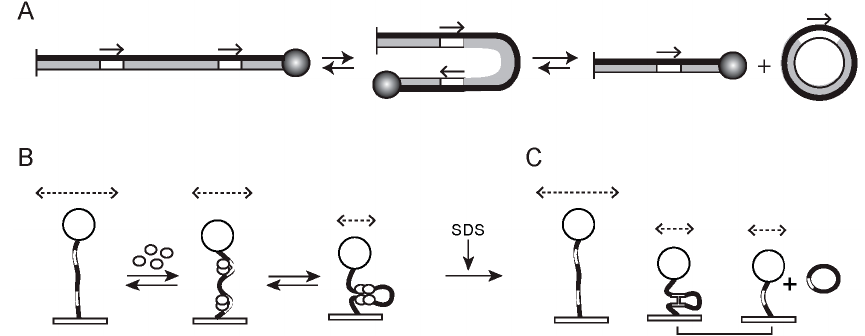
Figure 4. TPM analysis of tyrosine recombination between head-to-tail target sites. ( A ) The linear DNA substrate and the products of the recombination reaction are schematically drawn. The tethering surface and the polystyrene bead are shown as a short vertical line on the left and the sphere on the right, respectively. The relative orientation of the target sites is indicated by the direction of the arrows. ( B ) The changes in length of the DNA tether following the binding of the target sites by the recombinase and at subsequent steps of the recombination pathway are shown schematically. The relative magnitude of the BM amplitudes of the DNA–protein complexes are approximated by the lengths of the dashed, double-headed arrows drawn above the bead. The bound and bent target sites cause an apparent reduction in tether length, which is further accentuated by the synapsis of the bound sites. The exchange of one pair of strands to form the Holliday junction intermediate, or the completion of the excision reaction, will make this length reduction permanent. ( C ) The effect of removing the recombinase from the DNA by SDS addition is schematically illustrated. The non-synapsed molecules, as well as the synapsed molecules that failed to undergo strand exchange, will return to the starting BM amplitude of the DNA substrate, while the Holliday junction and the linear product of excision will retain their low BM amplitude state. The diagram is also applicable to serine recombination, with the following caveats. The conformational distortion or DNA bending introduced by serine recombinases is less prominent than that for tyrosine recombinases. The geometry of the sites within the activated synapse is parallel. As the strands are exchanged by a double strand break-join mechanism, no Holliday junction is formed during the reaction.